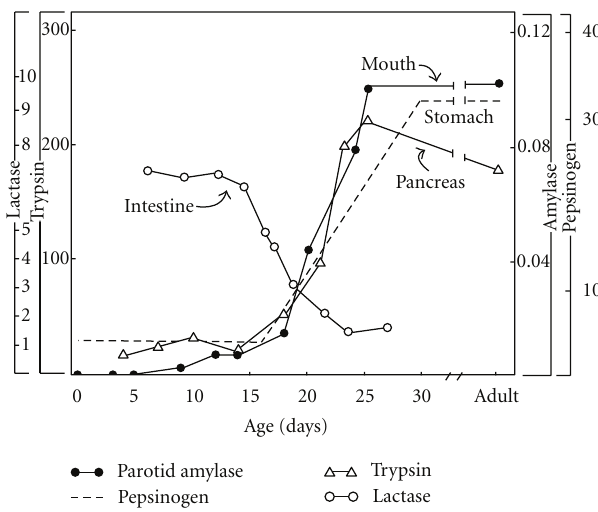
Figure 2: Developmental course of selected digestive elements of the mouth, stomach, pancreas, and intestine. Data were from [47, 50] and initially integrated in a discussion [51] that provides fuller reference